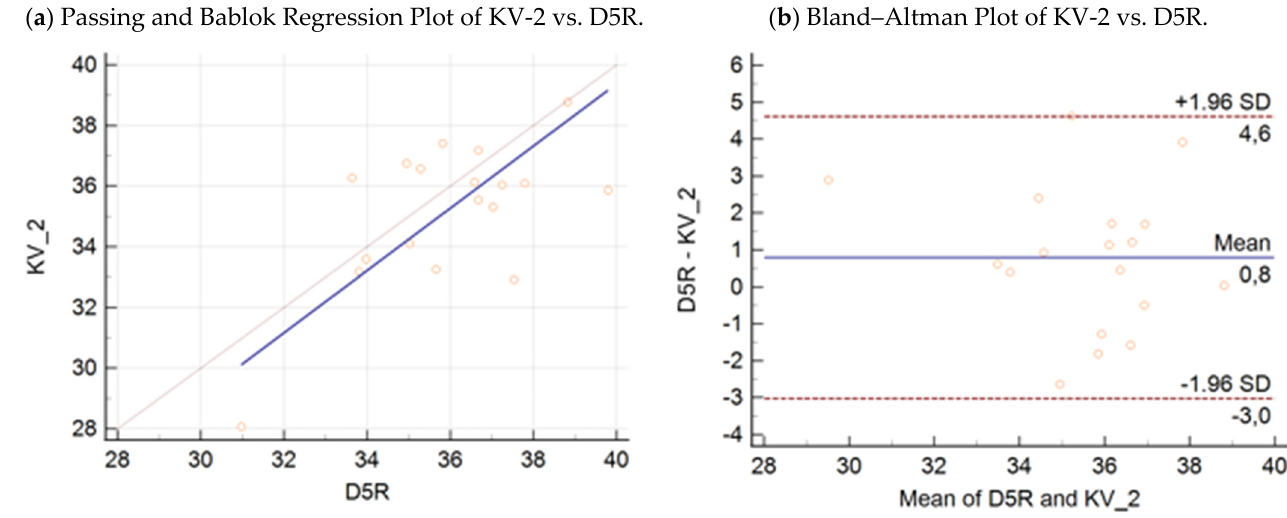
Figure 3. ( a ) Passing–Bablok regression plot: comparison of Ct values obtained with the wild-type KV-2 strain assay vs. Capripox-specific real-time PCR D5R assay, with 95% CI in 18 samples. ( b ) Bland–Altman plot: comparison of Ct values obtained with the wild-type KV-2 strain assay vs. Capripox-specific real-time PCR D5R assay, with 95% CI in 18 samples.